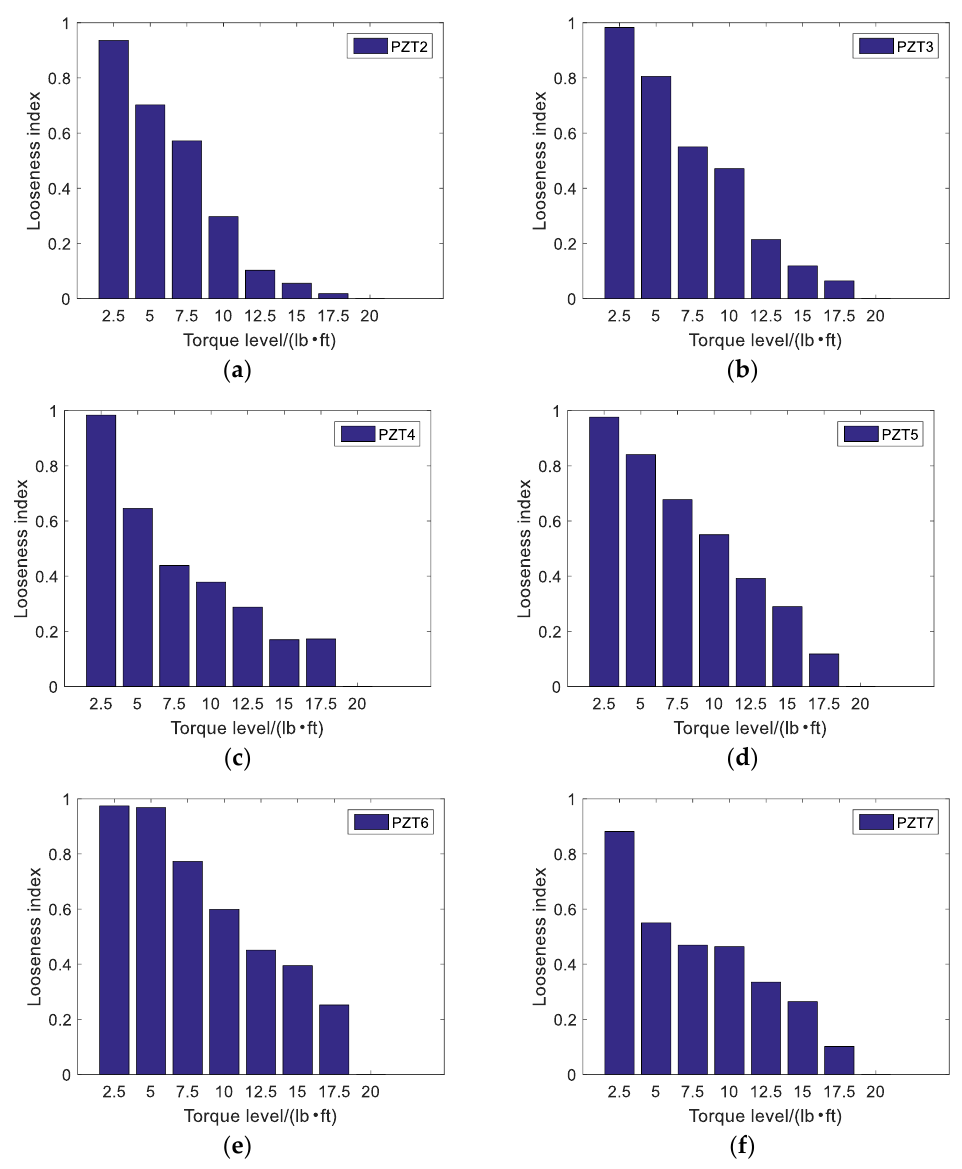
Figure 10. Looseness index at different torque levels: ( a ) Looseness index at PZT2; ( b ) Looseness index at PZT3; ( c ) Looseness index at PZT4; ( d ) Looseness index at PZT5; ( e ) Looseness index at PZT6; ( f ) Looseness index at PZT7.